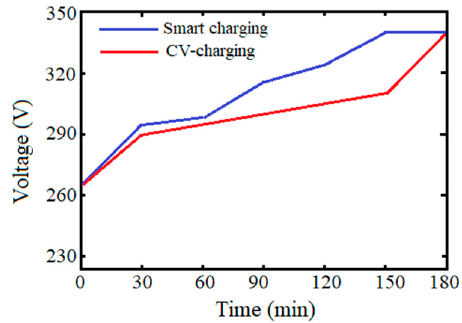
Figure 10. The measured battery charging curve.